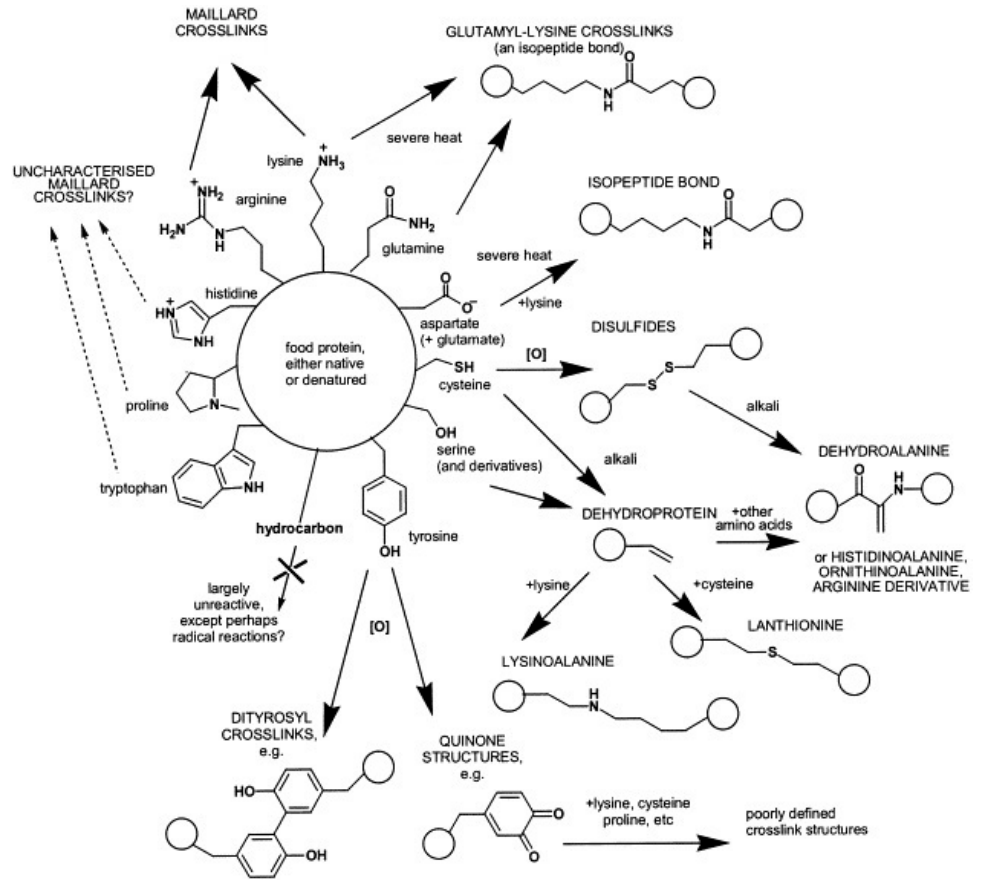
Figure 3. Summary of non-enzymatic cross-linking reactions that can occur during food processing, organised according to the amino acids that can react. Circles imply protein backbones. Reproduced with permission from [42], copyright by Elsevier Science Ltd., 2003.